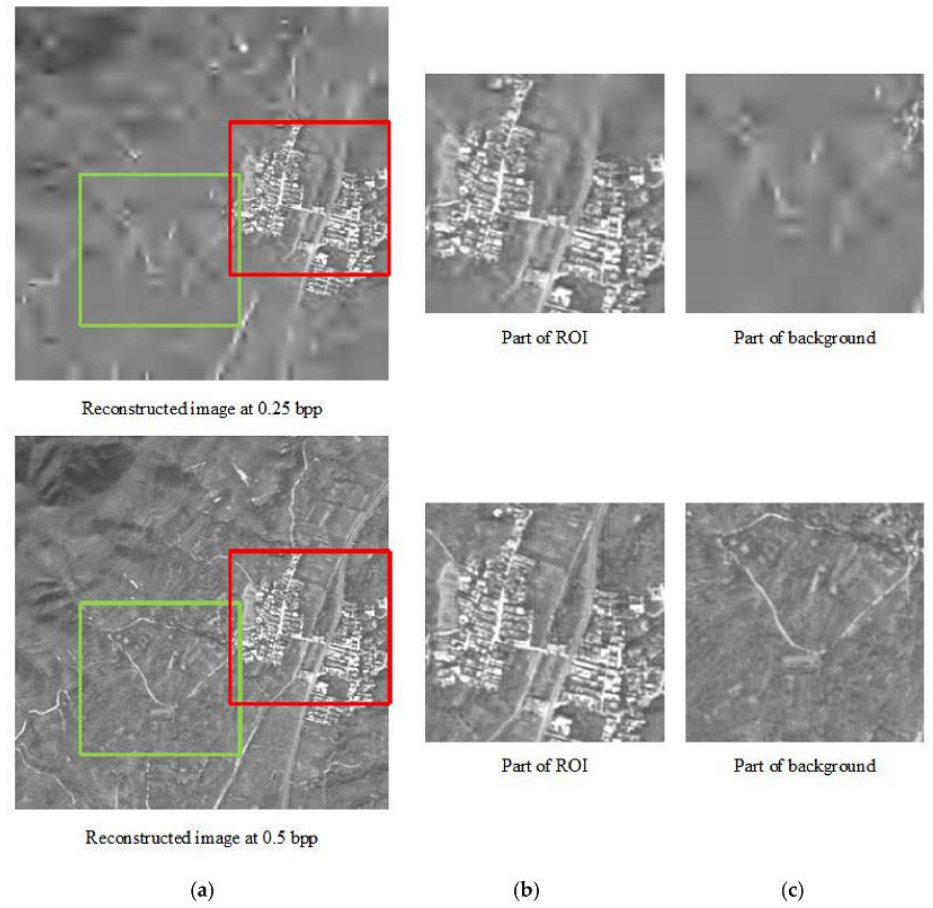
Figure 12. ROI compression example of remote sensing image. ( a ) reconstructed image; ( b ) part of ROI; and ( c ) part of background region. From top to bottom: reconstructed images are 0.5 bpp and 2.0 bpp,